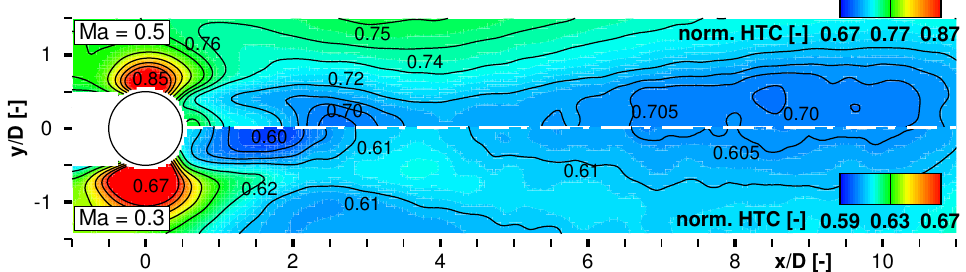
Figure 11. Quasi heat transfer coefficient norm.HTC = ( T w − T TSP ) / ( T TSP − T aw ) compared for Ma ∞ = 0.5 and Ma ∞ = 0.3 at maximum el. heat flux q (cid:48)(cid:48)